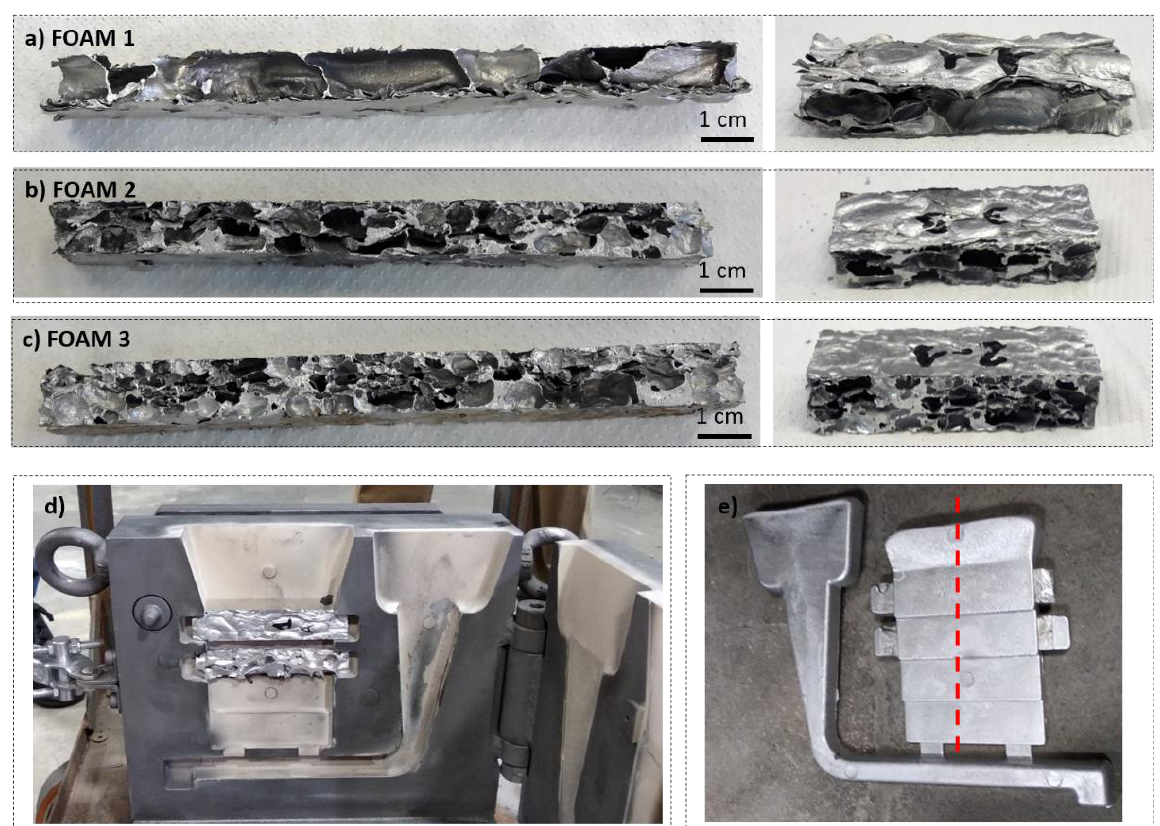
Figure 1. Cymat-type foam samples used in the experiments ( a – c ), ( d ) gravity casting die with foam inserts, ( e ) cast object with foam inserts.